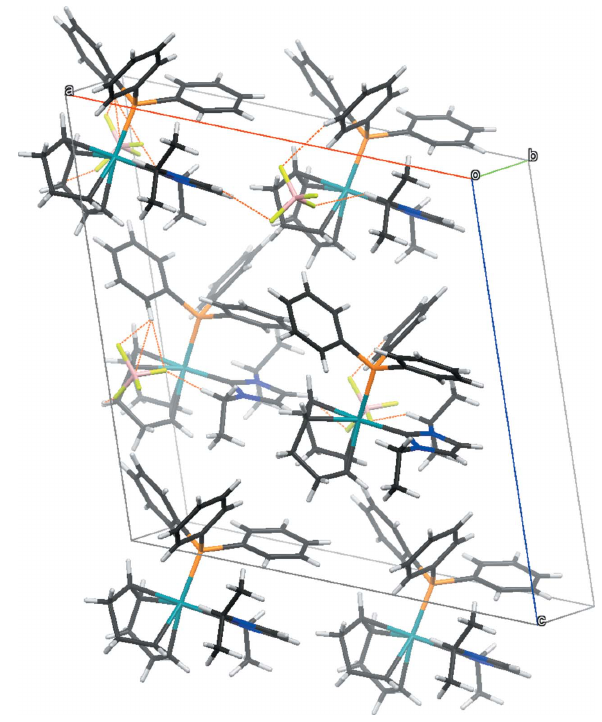
Figure 2 Crystal packing diagram of compound ( 4 ) with non-covalent interactions shown with dotted orange lines.